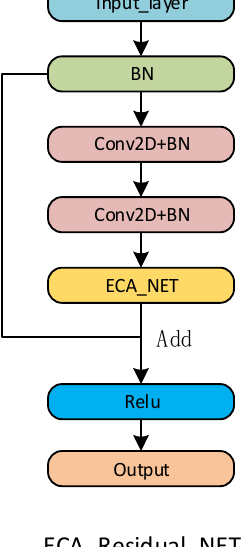
Figure 3. ECA residual net.